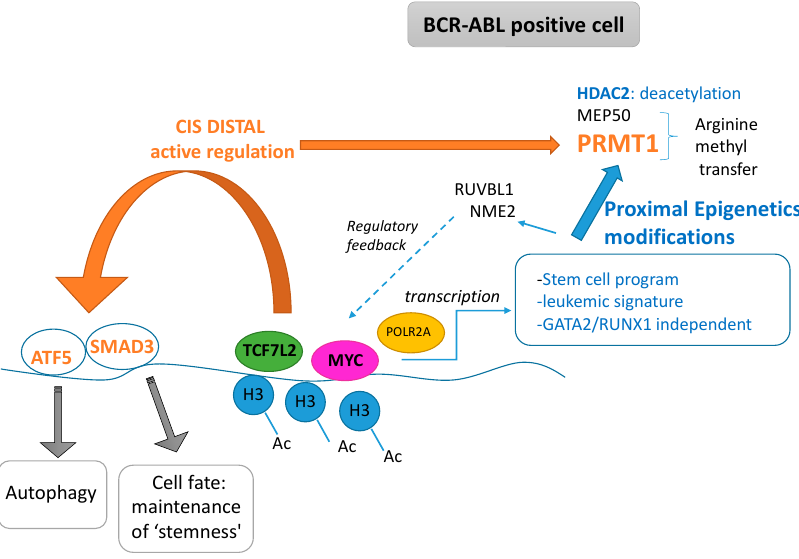
Figure 7. Pathophysiological model for cooperative role of TCF7L2 and MYC found in transcriptional program induced during CML blast crisis (Ac: acetyl, H3 histone H3).